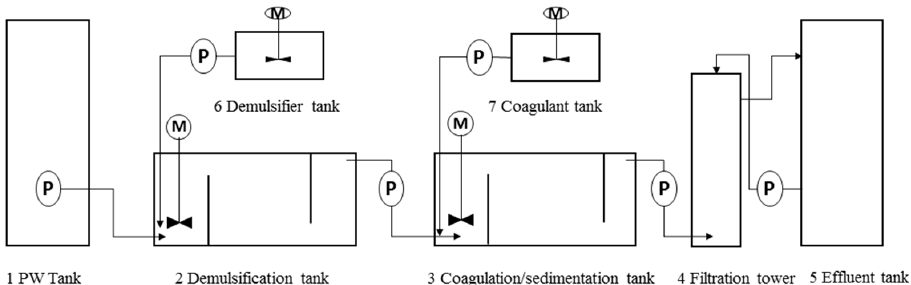
Figure 2. Flow diagram of the pilot experimental setup.